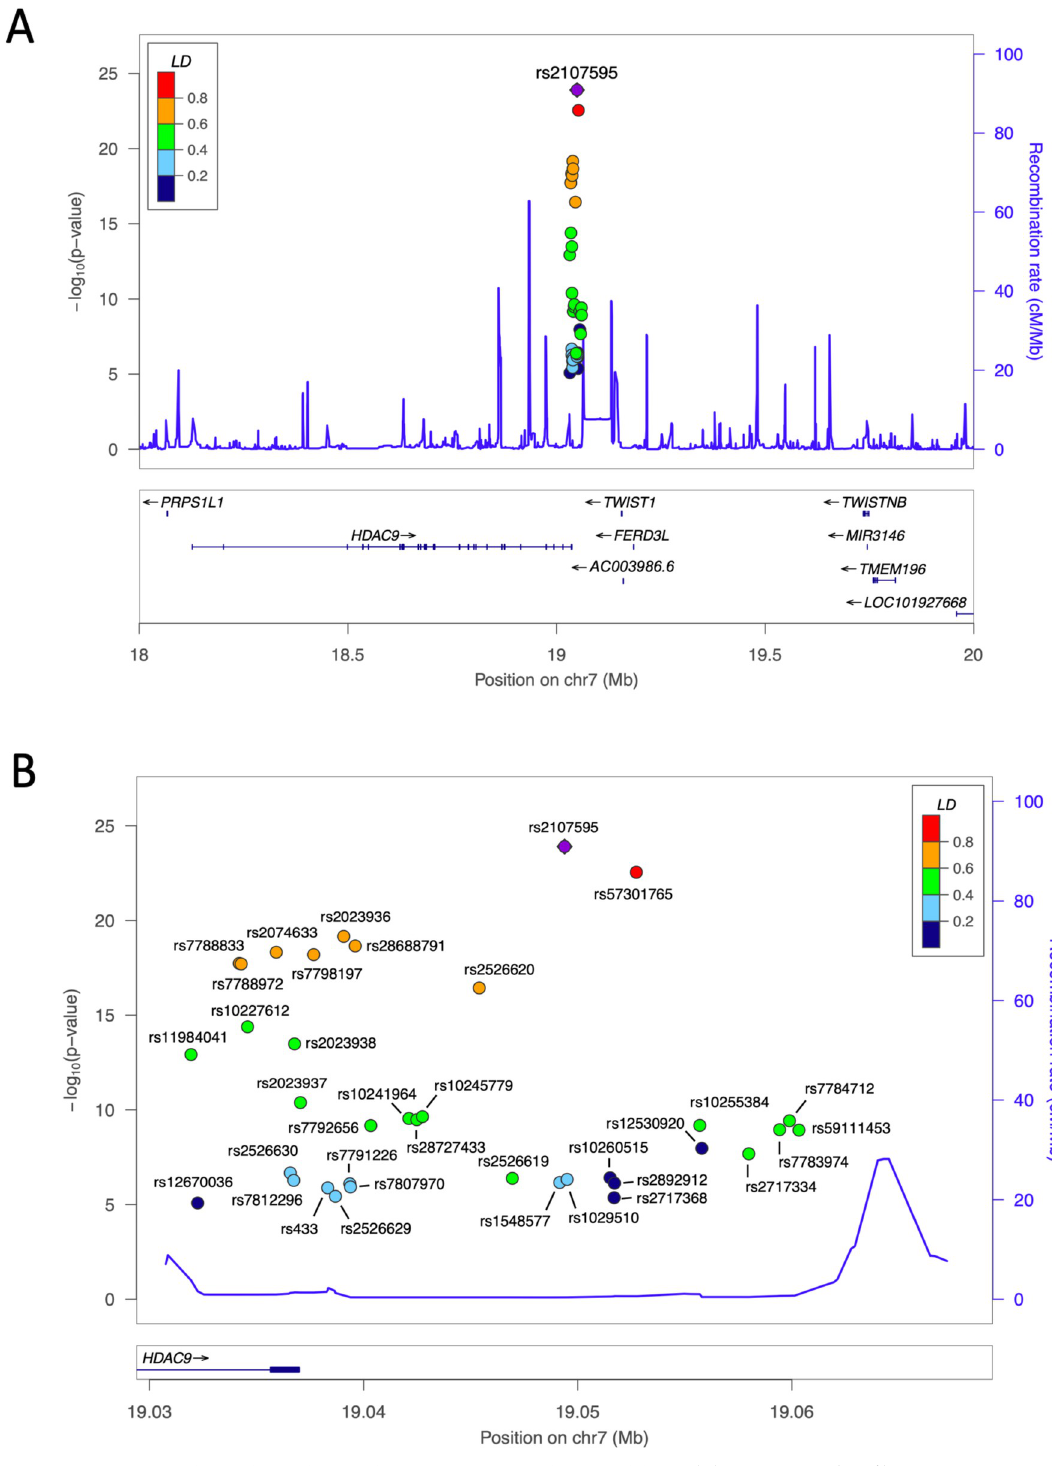
Fig 1. GWAS SNPs and LD relationships in the HDAC9 -associated CAD risk locus. (A) Locus zoom plot of known GWAS SNPs related to the risk of CAD, stroke and atherosclerotic aortic calcification in the vicinity of HDAC9 with rs2107595 showing the strongest correlation to CAD risk (lead SNP–shown in purple). Linkage disequilibrium (LD) relationships of each SNP with the lead SNP are color coded as indicated. (B) Further zooming of the locus plot as presented in A. LD relationships of each SNP with the lead SNP are color coded as